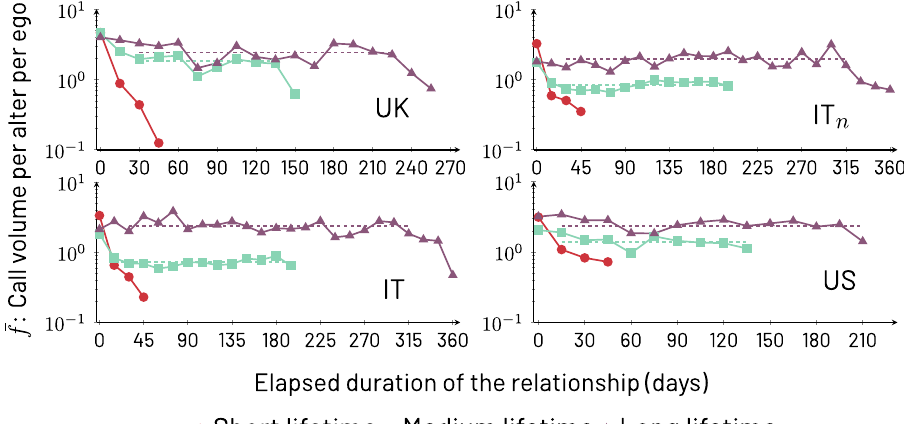
Figure 1. Average per alter per ego phone call volume ¯ f ( a , ℓ) as a function of elapsed relationship duration a , binned with (cid:31) a = 15 and �ℓ = 50 for the four cohorts shown. The lifetime groups correspond to ℓ = 0 (short), ℓ = ⌊ ( L E − �ℓ)/ 2 ⌋ (medium), and ℓ = L E − �ℓ (long). To calculate the exact ℓ per country, as stated in Fig. S1 of the Supplementary Information, we use L UK = 270 ; L IT n = 365 ; L IT = 365 ; and L US = 220 . The transient condition is (cid:31) t w = 60 days, and for cohort IT n , the gap between the entry of an ego and the acceptance of an ego-alter pair is set to (cid:31) t s = 50 days. The number of resulting ego-alter pairs induced by our selection criteria is reported in Table 2. Robustness checks with different values for parameters �ℓ , � a , � t w , and (cid:31) t s are shown in the Supplementary Information, Sect. S3. The curves are stable for medium and long lifetime groups. For curves displaying stable regions, we show a dashed line that represents b (ℓ) , the average number of phone calls to alters of a given ℓ during the stable regime of communication.